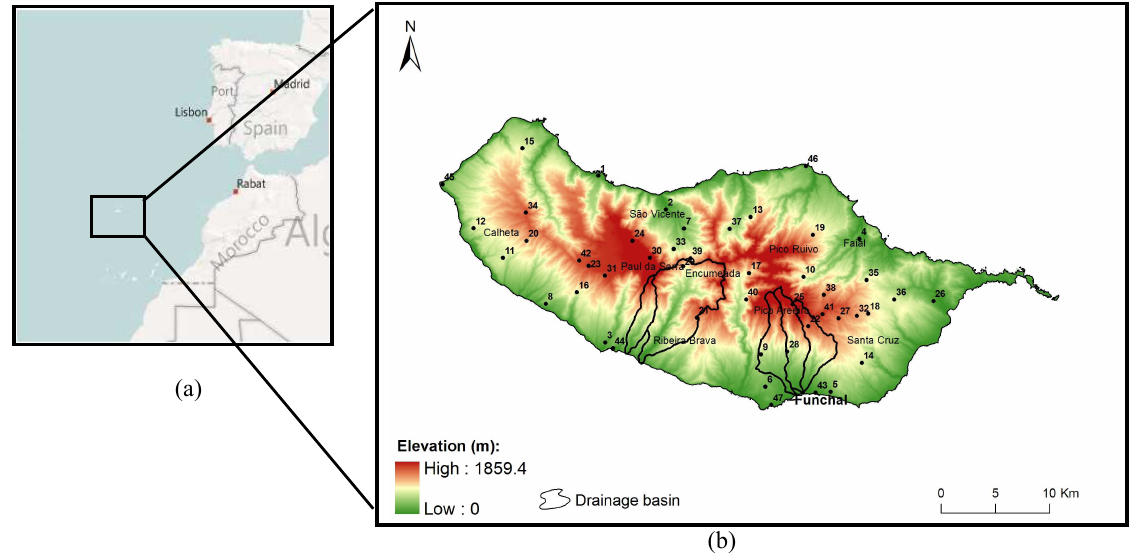
Fig. 1. Location (a) and relief (b) of the island of Madeira (Portugal). Dots are locations of the rain-gauge stations used in this study (names and description in Table 1). Limits of the drainage basins affected by the 20 February flash-floods and landslides are also shown (names and description in the text). Table 1. Main flash-flood events in Madeira between 1800 and 2010 (SRES, 2010). Most affected